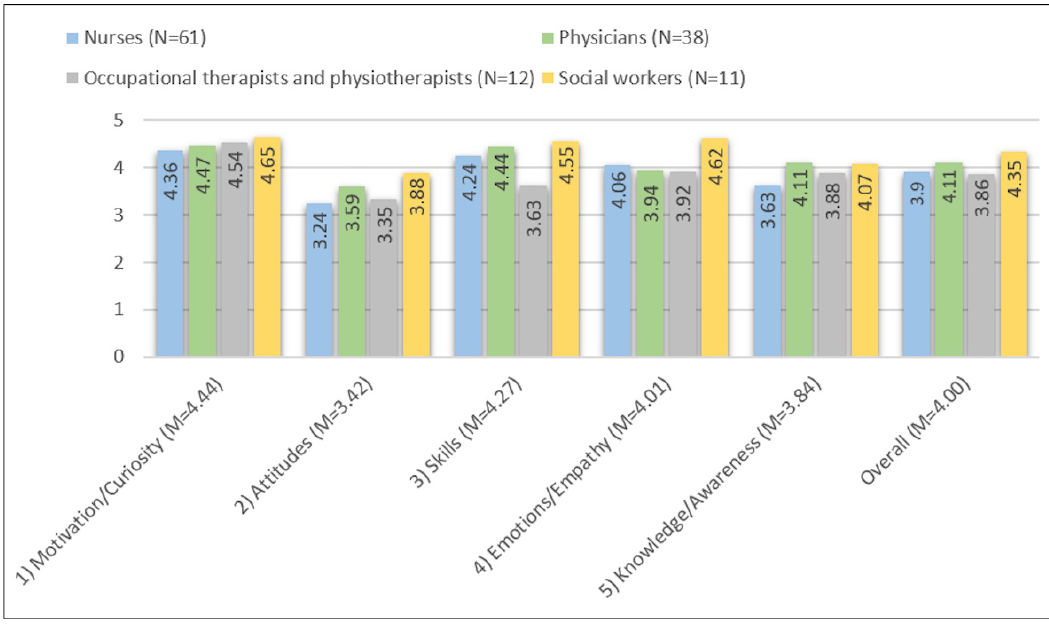
Figure 3: Means for Cross-Cultural Competence of Healthcare Professionals (CCCHP) scales.